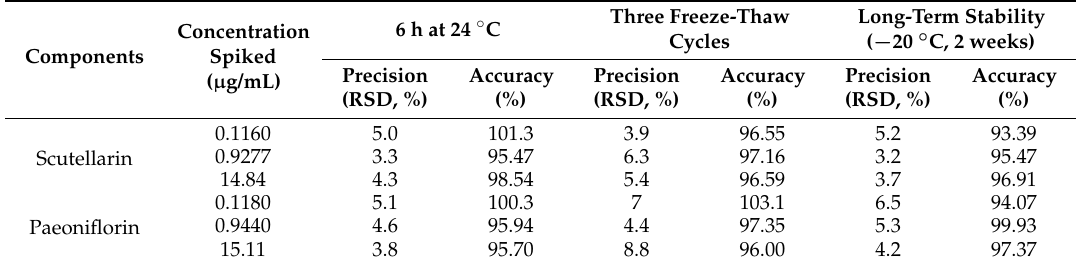
Table 3. Stability of scutellarin and paeoniflorin in rat plasma under various storage conditions ( n = 5). Concentration Components